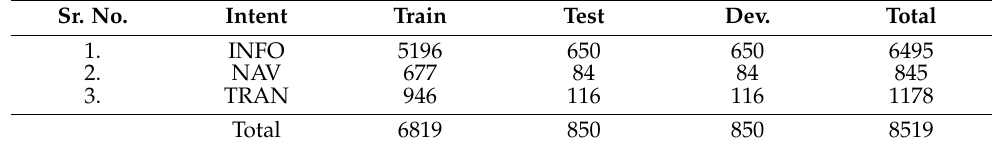
Table 7. Intent-wise division of Urdu web queries dataset in train and test